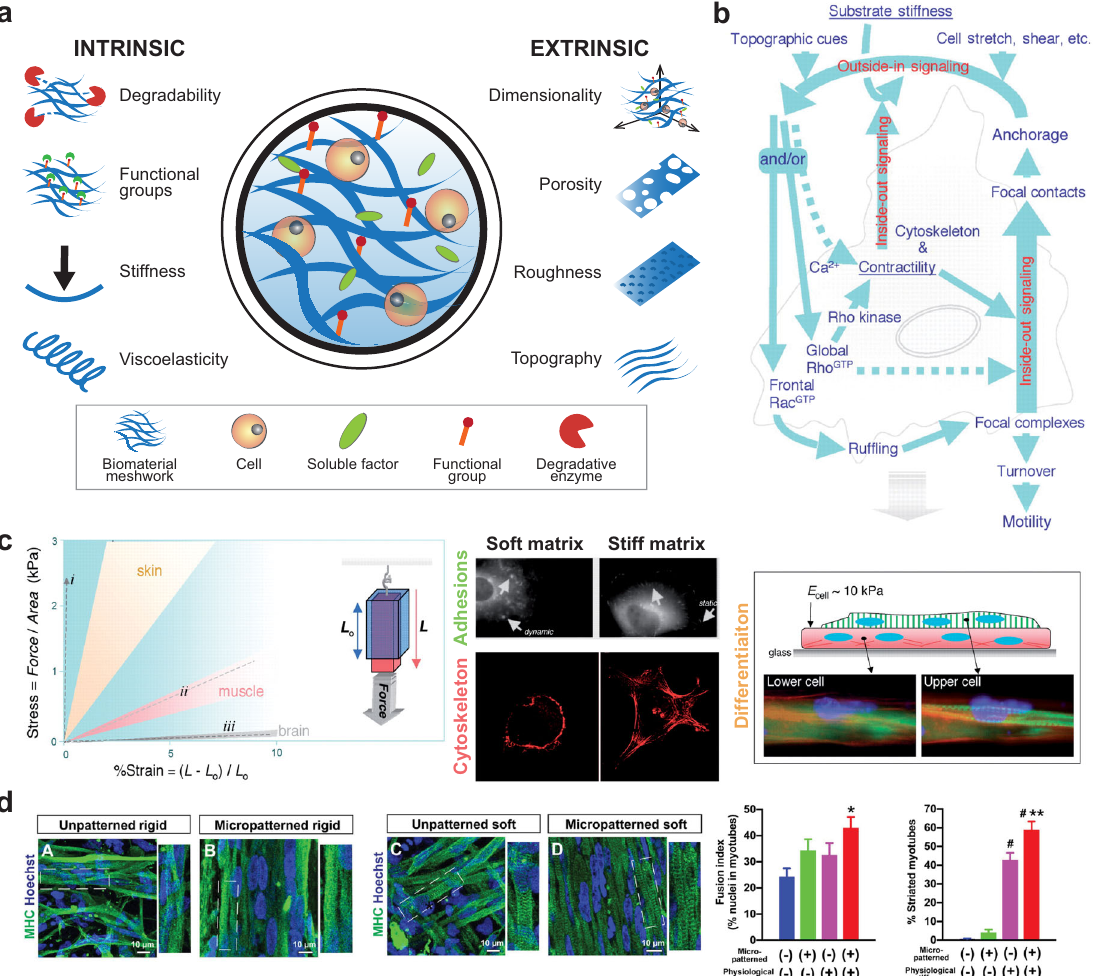
Fig. 4 Biomaterial features and their effects on skeletal muscle cells. a Scheme of biomaterial properties relevant for cell/tissue engineering, divided into intrinsic and extrinsic ones. b Scheme of the intracellular biochemical cascades triggered by the stiffness of the extracellular environment. Images reproduced with permission from 126 . c Top: stress/strain curves for different soft tissues (skin, muscle, and brain) from which the slope E can be extracted, representing the Young ’ s elastic modulus. Dashed lines represent (i) polylactic acid; (ii) artery- derived acellularized matrix; (iii) Matrigel ® . Bottom: in fl uence of soft and stiff matrix on actin cytoskeleton assembly, cell spreading, and myotube differentiation. Images reproduced with permission from 126 . d Left: immuno fl uorescence staining of iPSC-derived myotubes at two weeks of differentiation on different substrates. Right: evaluation of the fusion index and percentage of striated myotubes in the different conditions. ( N = 10 fi elds). * p < .05 versus unpatterned rigid. # p < .05 versus unpatterned soft and micropatterned rigid, and ** p < .05 versus unpatterned soft. Images adapted and reproduced with permission from 30